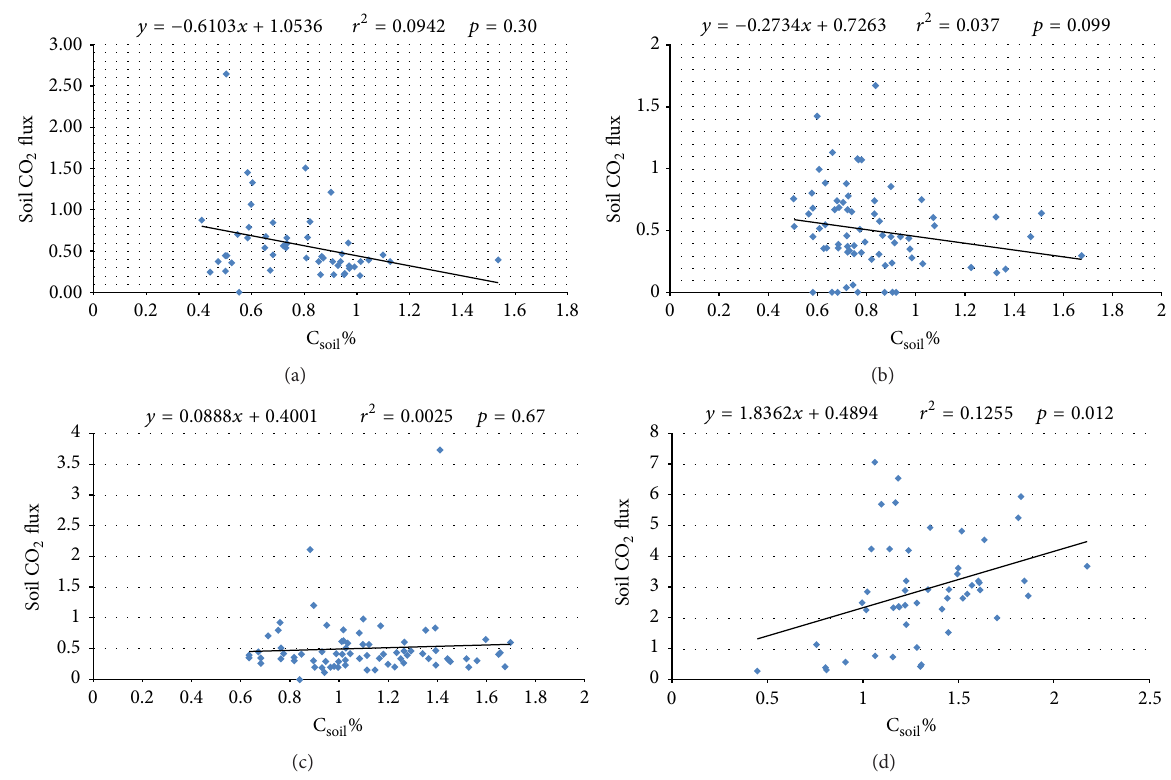
Figure 5: Scatter plots of soil carbon versus soil CO 2 flux for individual samples shown for all four treatments, with slope and 𝑟 2 of regression line: (a) = control; (b) = fertilizer/grass; (c) = grass, birch, and willow; (d) = lupine.